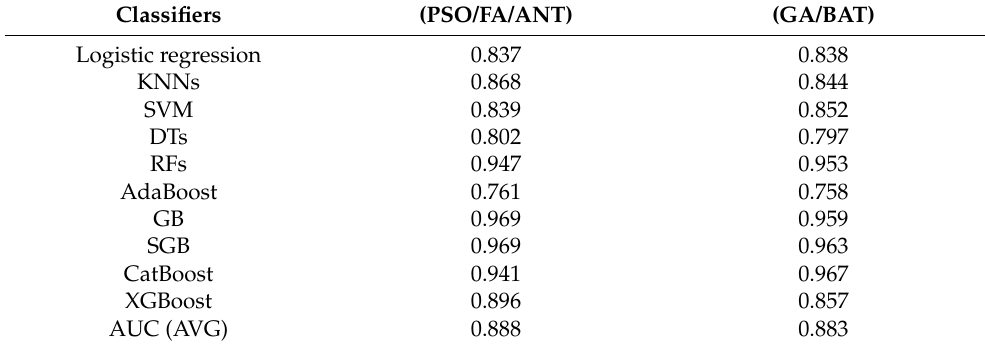
Table 8. Classifier AUC